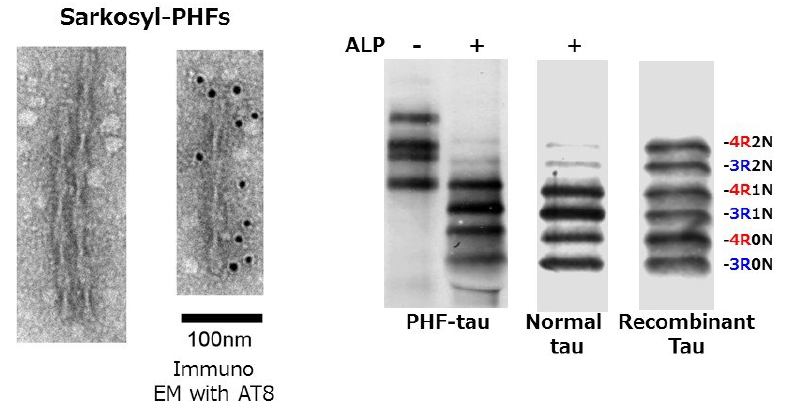
Figure 1. EM pictures of paired helical filaments in Sarkosyl-insoluble fraction prepared from AD brain, and the immunoblot analysis of tau before and after alkaline phosphatase (ALP) treatments, compared with soluble human tau and six recombinant human tau